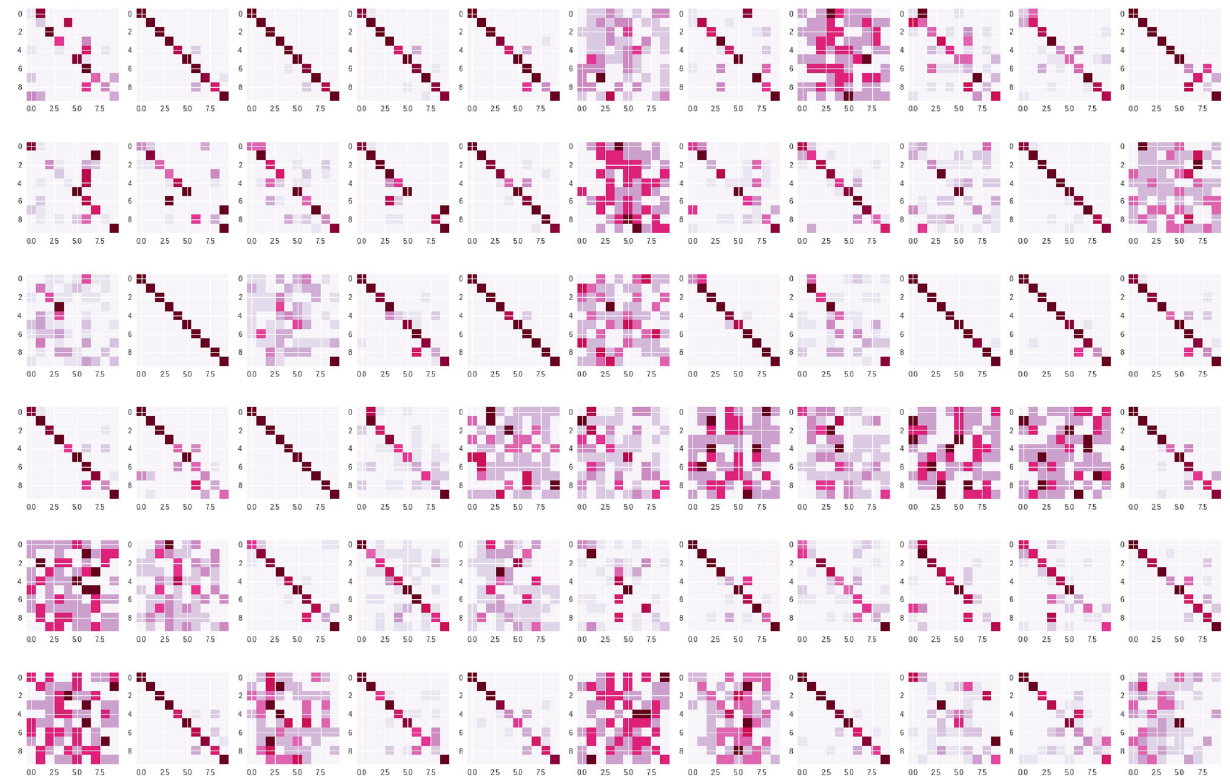
Figure 25. Confusion matrix of all 66 students over the quiz set; the overall error profile is very dissimilar to ML models; only the best performing students produced a similar error profile as that of the VML model (Figure generated by Matplotlib python library, version 3.3.4, https:// matpl otlib. org/).